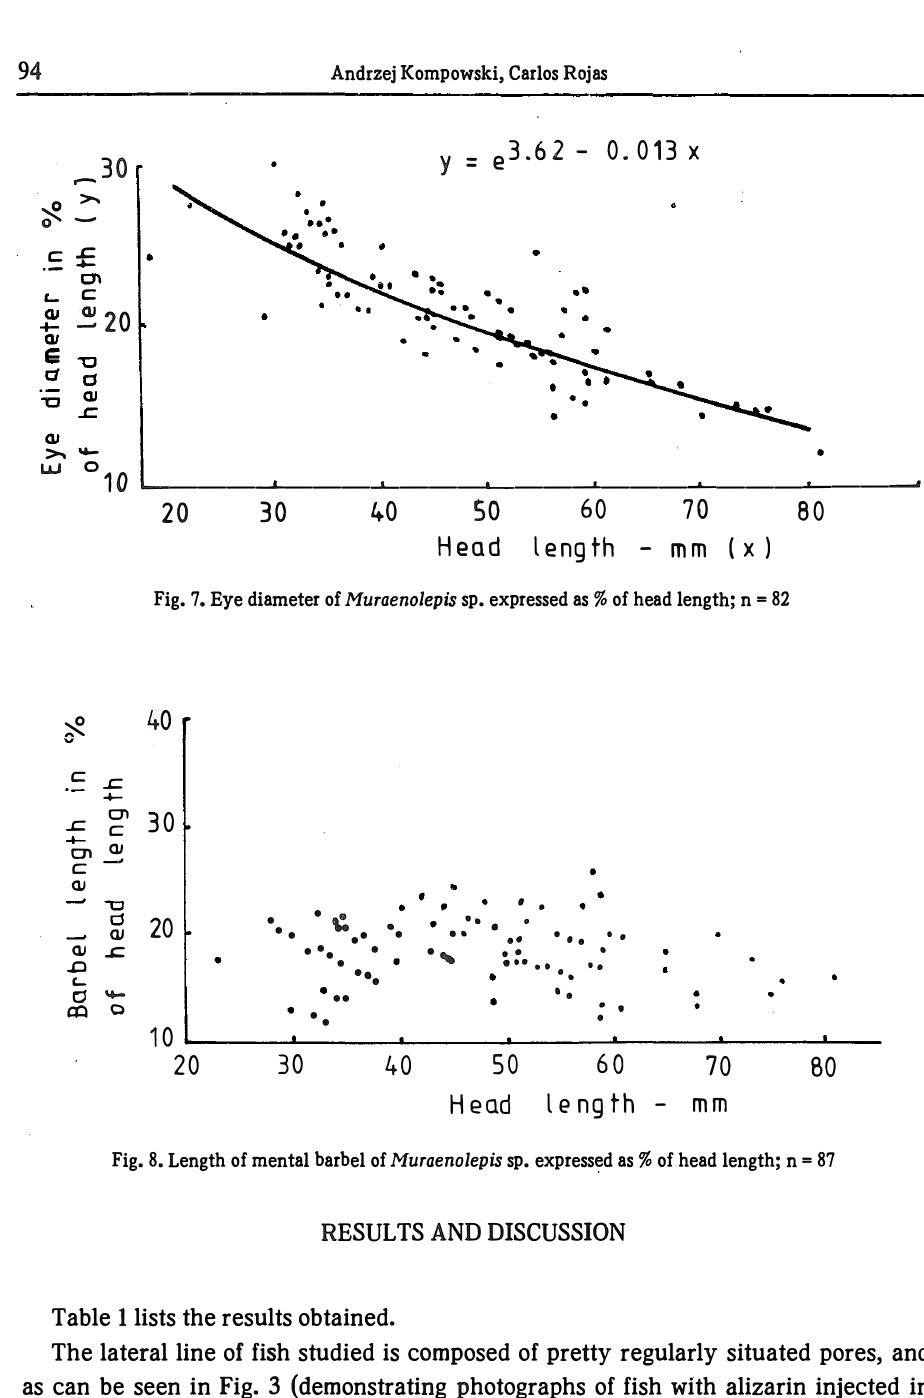
Fig. 8. Length of mental barbel of Muraenolepis sp. express�d as% of head length; n =